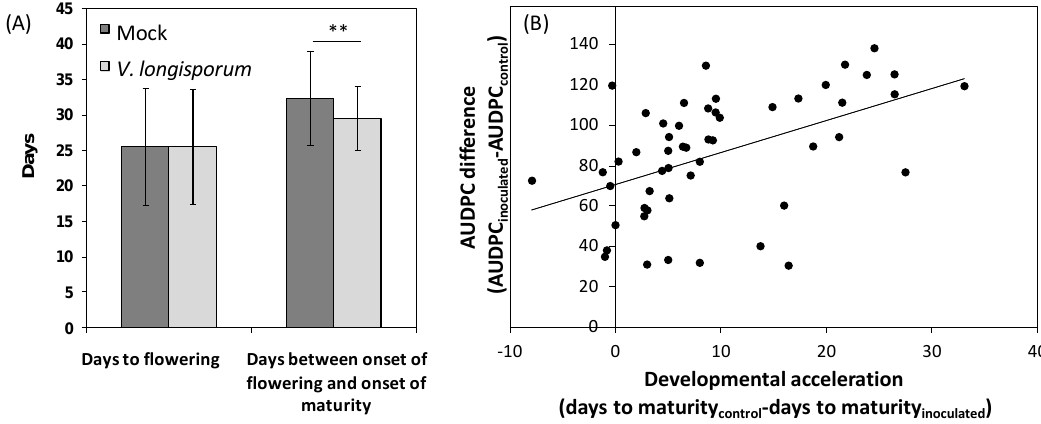
Figure 4. Developmental acceleration in A. thaliana and B. alboglabra after V. longisporum infection. (A) Flowering time and maturation time in a collection of 100 A. thaliana (Bur × L er )-recombinant inbred lines (RILs) after mock- and V. longisporum inoculation respectively. N = 94 to 102, each replicate corresponded to a batch of at least 15 plants. Asterisks denote a significant difference of p < 0.01 ( t -test), error bars denote standard deviations. (B) Correlation between developmental acceleration by V. longisporum and disease progression, expressed as AUDPC difference between inoculated and mock-inoculated plants in B. alboglabra (94 × 99)-F3-families. N = 52, r = 0.49, p < 0.01. Each data point represents one F3-family, differences were calculated from means of 38 inoculated and 11 mock-inoculated plants in each